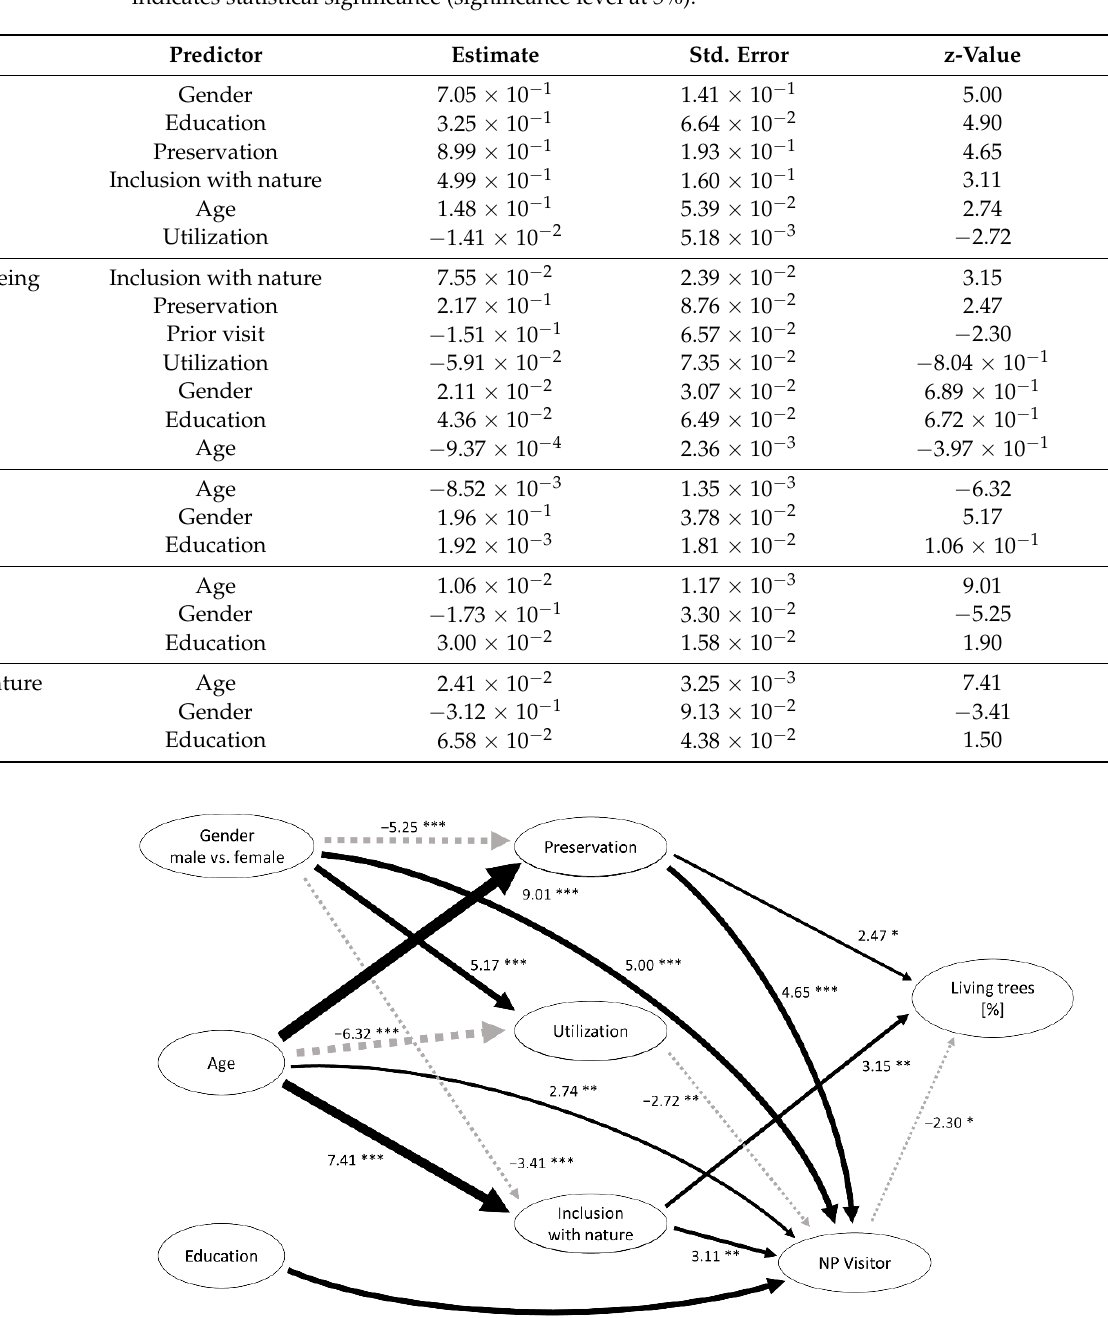
Table 1. Results of the structural equation model testing the influence of age, gender, education level, preservation, utilization, and inclusion with nature on prior visits and subjectively perceived well-being ( n = 1008) using generalized linear models. The influence of gender, age, and education level on utilization, preservation, and inclusion with nature was tested using linear models. Boldface indicates statistical significance (significance level at 5%).